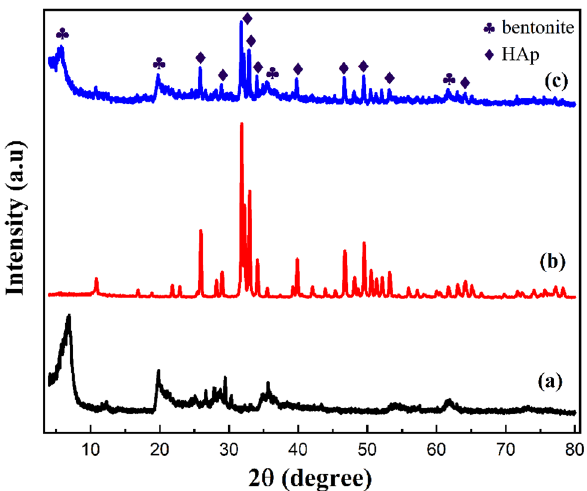
Figure 2. XRD pattern of ( a ) bentonite, ( b ) HAp, and ( c ) HAP/ bentonite composite.